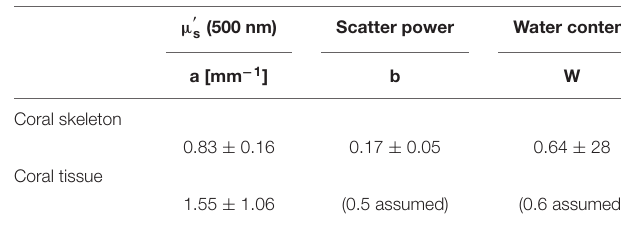
TABLE 2 | Average of coral tissue and skeleton optical